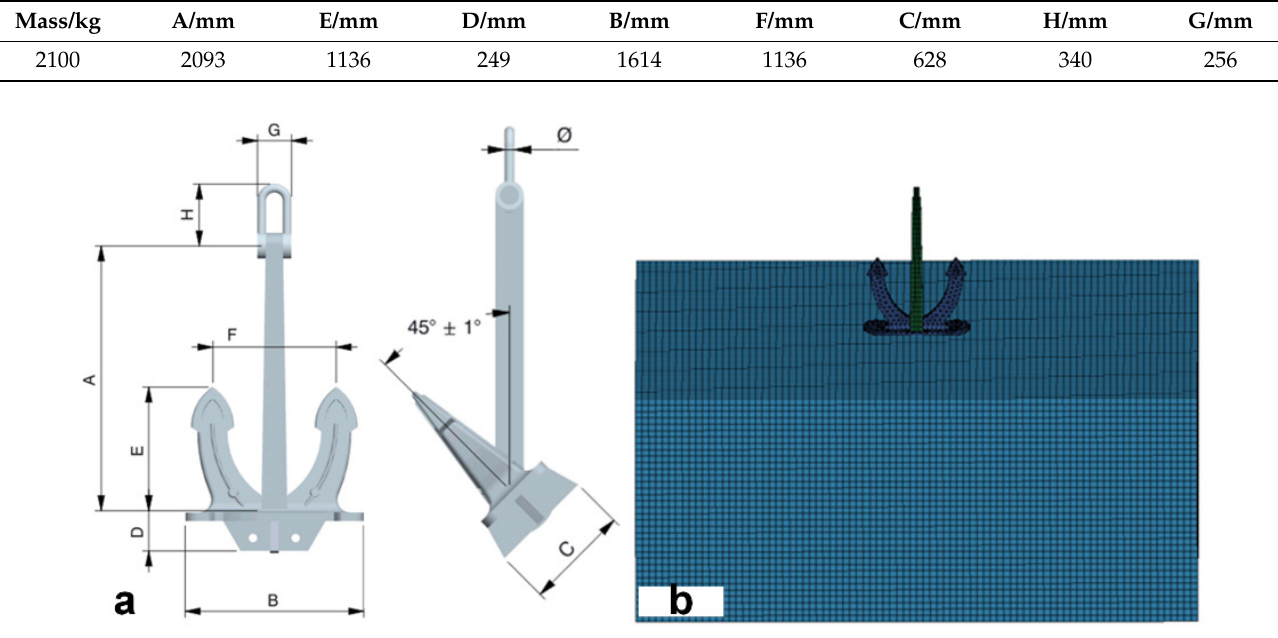
Table 5. The parameters of the sandy clay in Zhoushan Island.